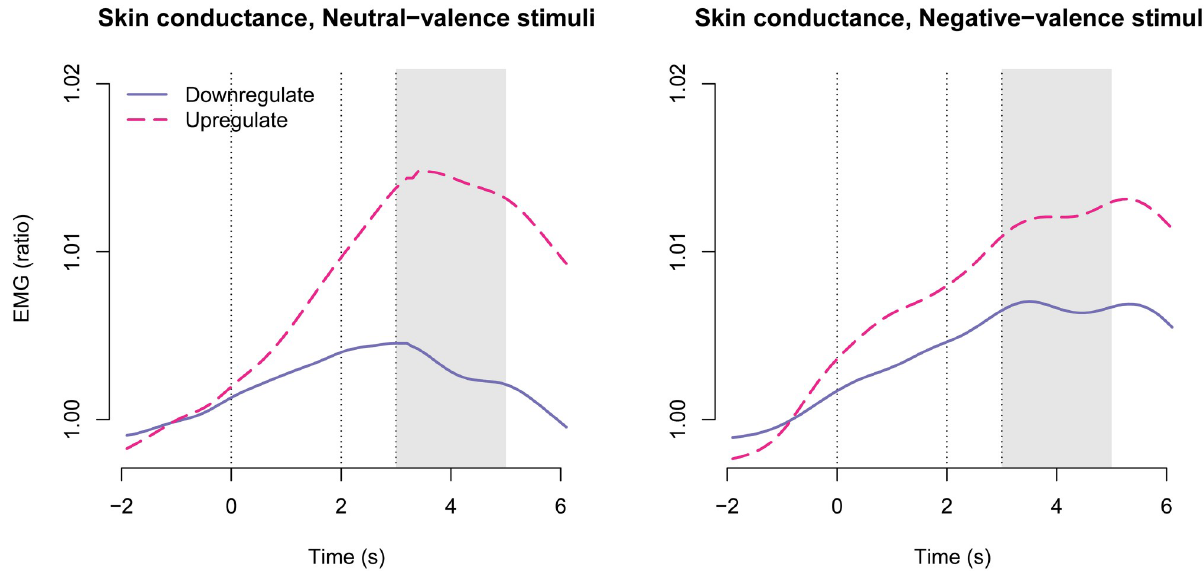
Fig 3. Skin conductance time-courses across treatment groups. The first vertical line shows regulation instruction onset; the second vertical line shows stimulus image onset; and the third vertical line shows stimulus image offset. The shaded gray area shows the time window from which responses were averaged for statistical